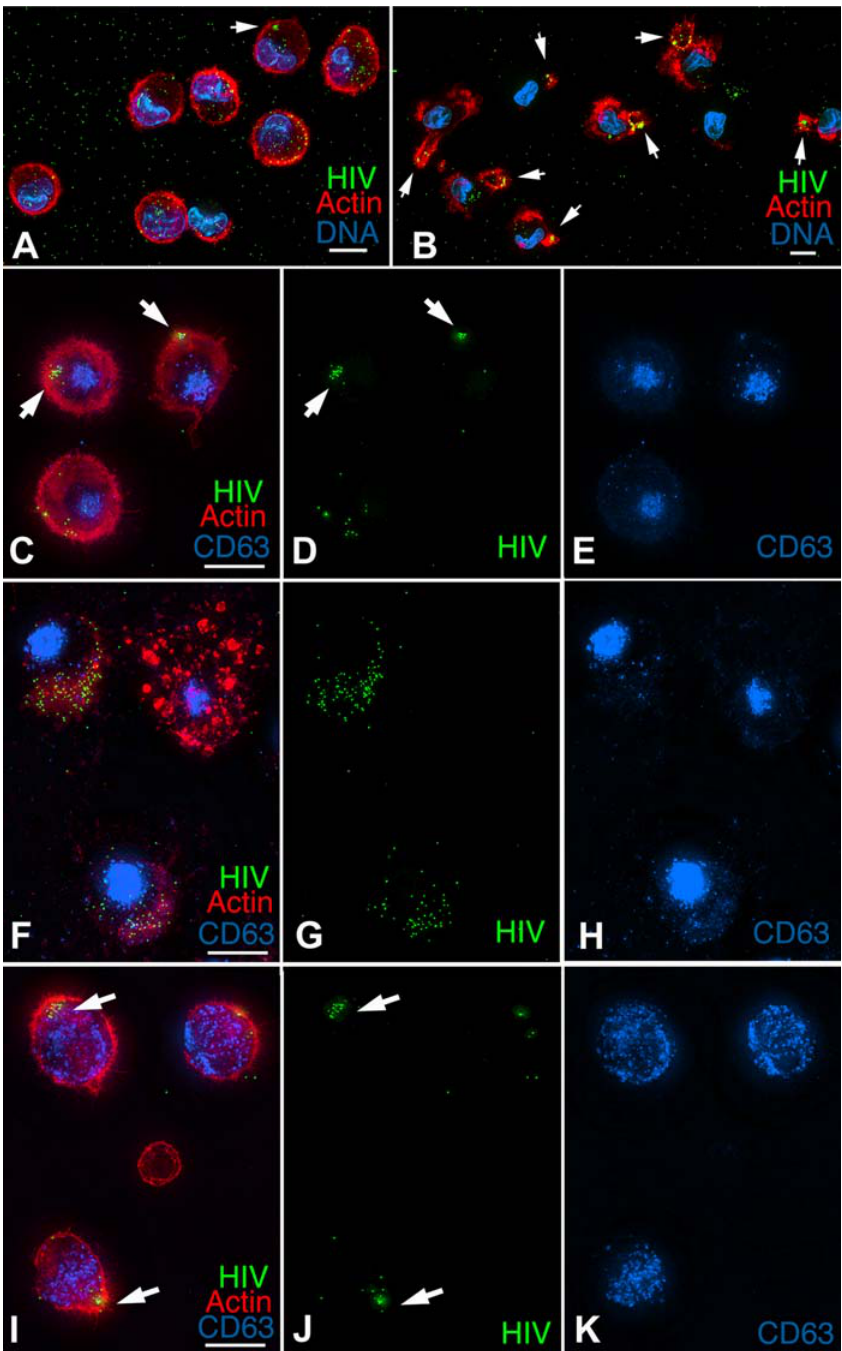
Figure 1. HIV concentration in mature MDDCs requires an intact actin cytoskeleton. (A,B) Mature DCs were plated onto coverslips, pulsed with HxB2 pseudotyped GFP-Vpr HIV (green) for 30 min, washed and fixed (A) or incubated an additional hour and fixed (B). Fixed cells were stained for actin cytoskeleton (red) and nuclear DNA (blue). (C–K) Mature MDDCs were pre-incubated for 15 min without (C–E) or with cytoskeletal inhibitors latrunculin B (2.5 m M) (F–H) or nocodazole (5 m M) (I–K) and then incubated with GFP-Vpr HIV (green) for 1 h with appropriate inhibitors. Cells were washed and incubated for 1 h with inhibitors, plated onto coverslips, and fixed and stained for cellular CD63 (blue) and actin (red). Note the perinuclear CD63-positive lysosomes were re-distributed in nocodazole-treated cells (I–K) and the actin cytoskeleton was disrupted in latrunculin B treated cells (F). Images are 3-D–rendered whole-cell volumes, arrows denote areas of concentrated HIV. Bars, 5 m . doi:10.1371/journal.ppat.1000134.g001 was highly concentrated along with the HIV, as has been reported monoclonal antibodies comprising a variety of cell surface and intracellular markers (Figure 2). We identified a number of previously [6,7]. High resolution imaging showed that CD81 and proteins that co-localized with the concentrated HIV. CD81, a HIV were concentrated into a compact, apparently intracellular member of the tetraspanin family of integral membrane proteins, structure (Figure 2A–2C). Before exposure to HIV, CD81 was